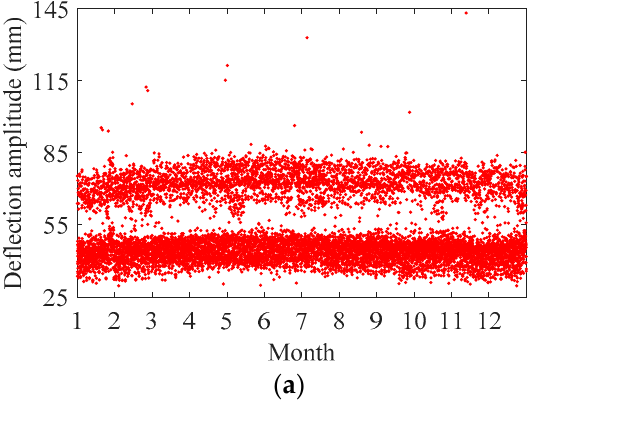
Figure 5. Amplitude of each non-stationary section of train-induced response at Section G in one year: ( a ) deflection; ( b ) acceleration.